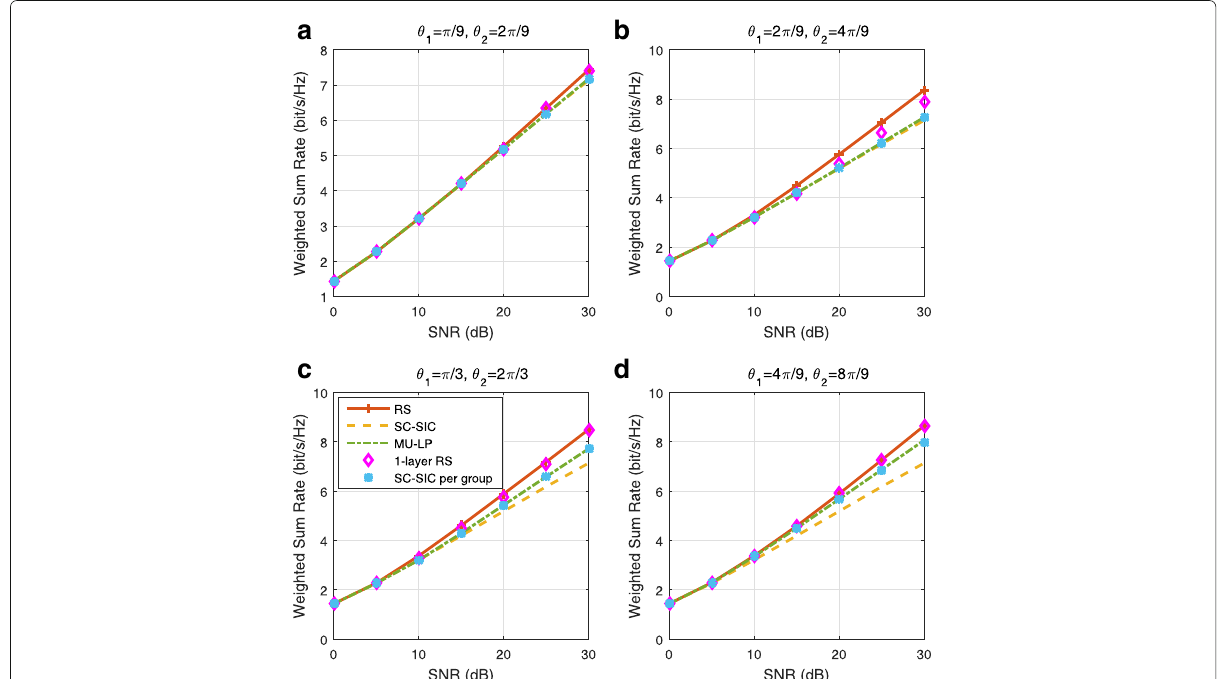
Fig. 48 Weighted sum rate versus SNR comparison of different strategies for underloaded three-user deployment with imperfect CSIT, γ 1 = γ 2 = 1,